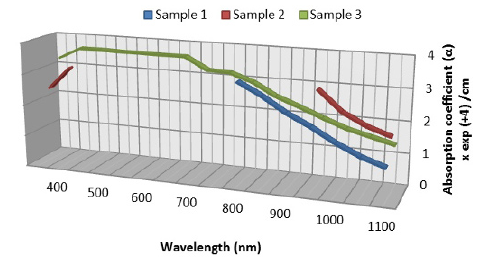
Figure 5. Plot of absorption coefficient ( α ) vs. wavelength ( λ ) for three CuInSe 2 films The general expression for the absorption by excitation Figure 7. Plot of extinction coefficients for three CuInSe 2 films of electron across a direct band gap ( E ) is given by the g